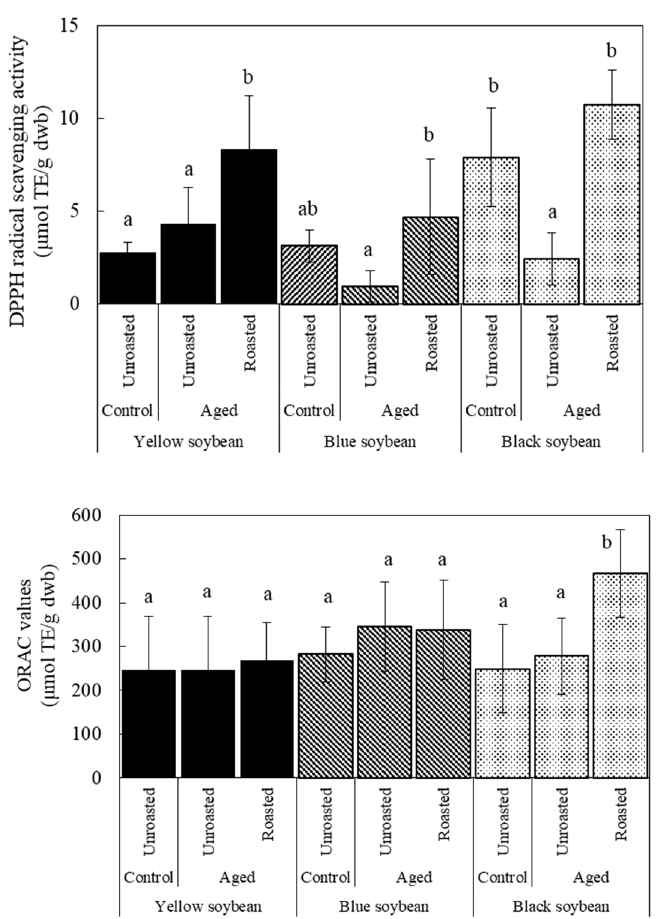
Figure 4. DPPH radical scavenging activity and ORAC values of soybeans affected by storage and roasting. Control were stored at 4 °C/80% RH for 60 days; Aged beans were stored at 30 °C/75% RH for 60 days. Roasting condition was 190 °C for 20 min. Significant differences within the same bean are indicated by lowercase letters a, b, and c. p < 0.05. n = 3.